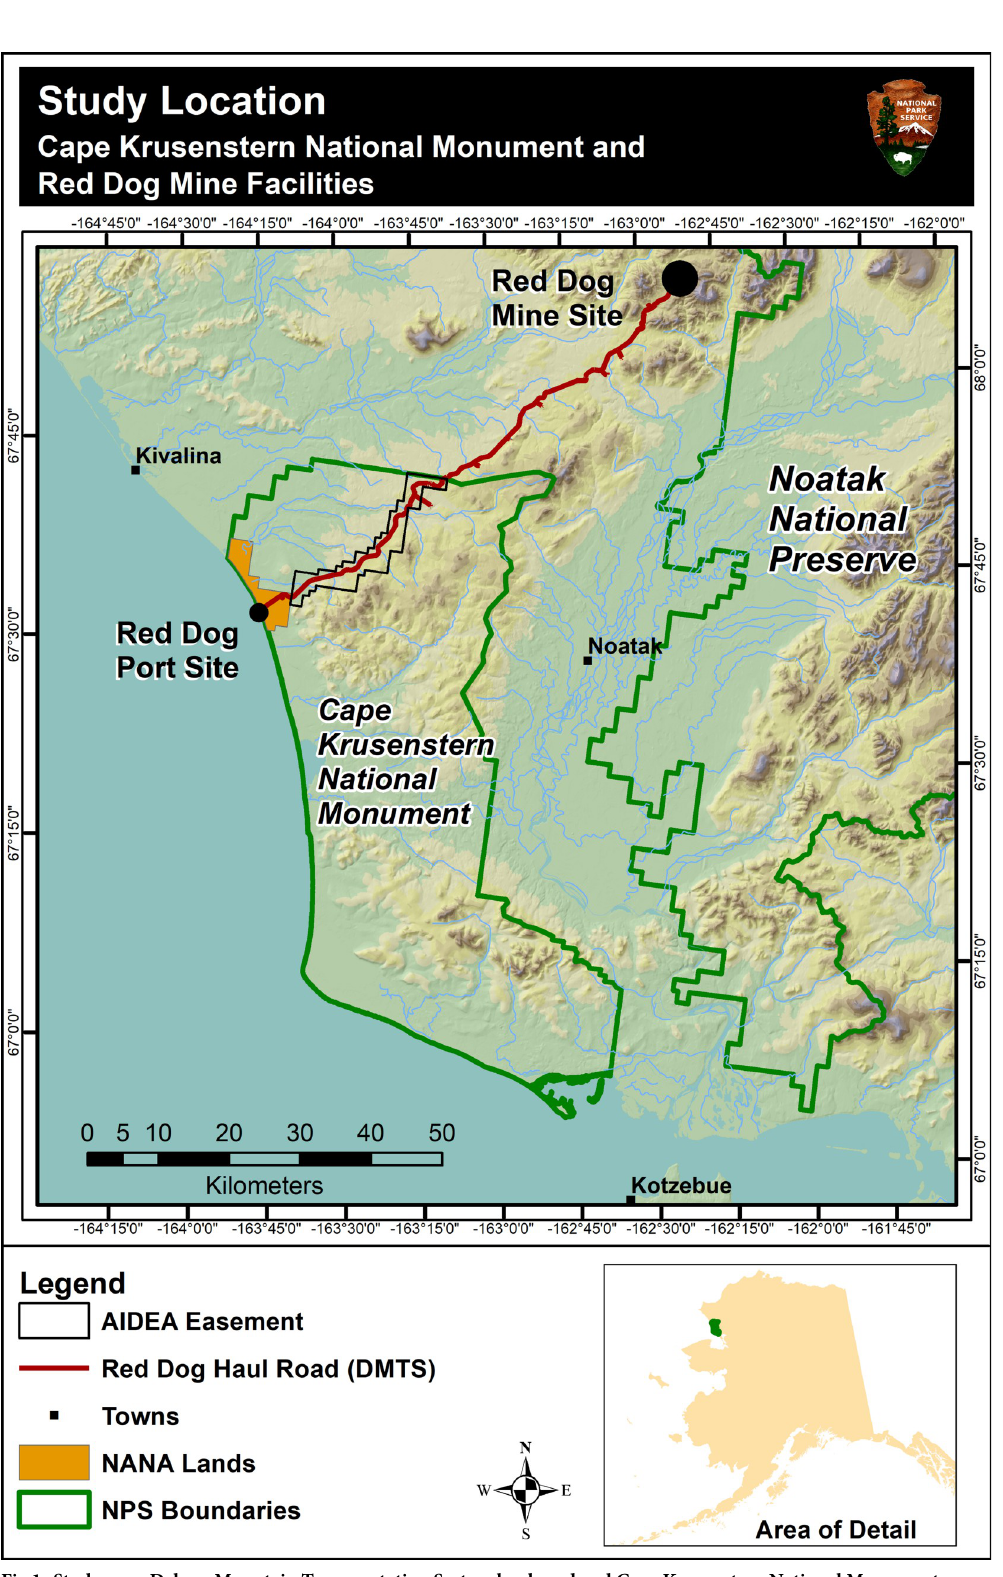
Fig 1. Study area: Delong Mountain Transportation System haul road and Cape Krusenstern National Monument, Alaska. Thirty-two km of the haul road traverses an industrial easement through the monument. Geographic coordinates